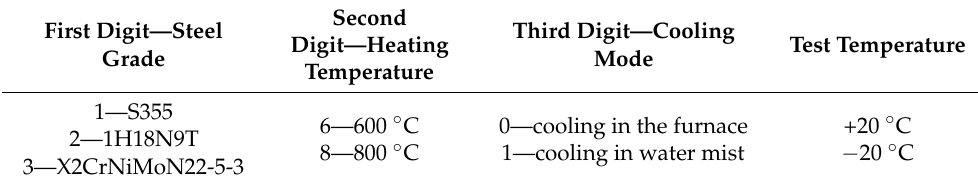
Table 1. Description mode of the samples subjected to impact